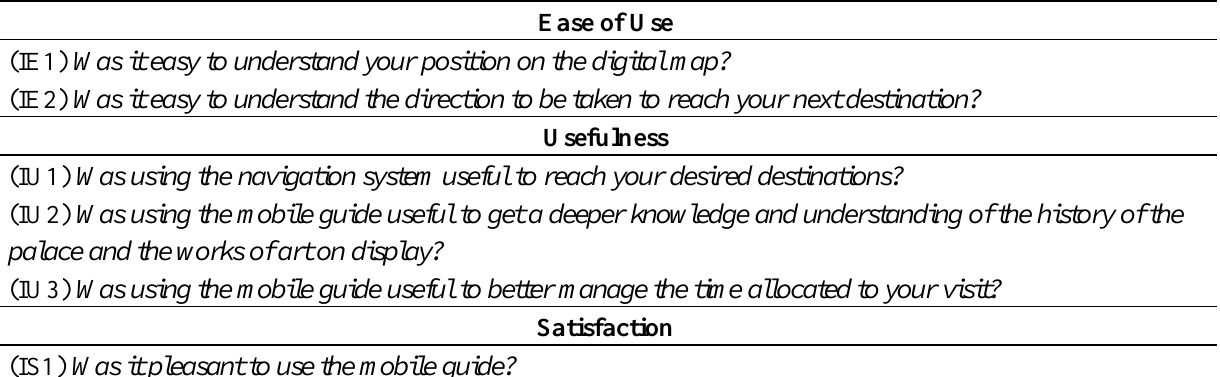
Table 1. Outline of the semi-structured